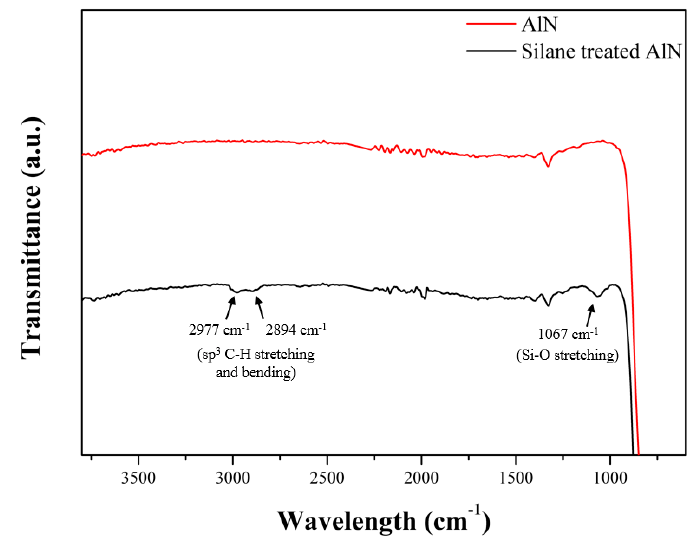
Figure 2. FT-IR spectra of the AlN and silane treated AlN.